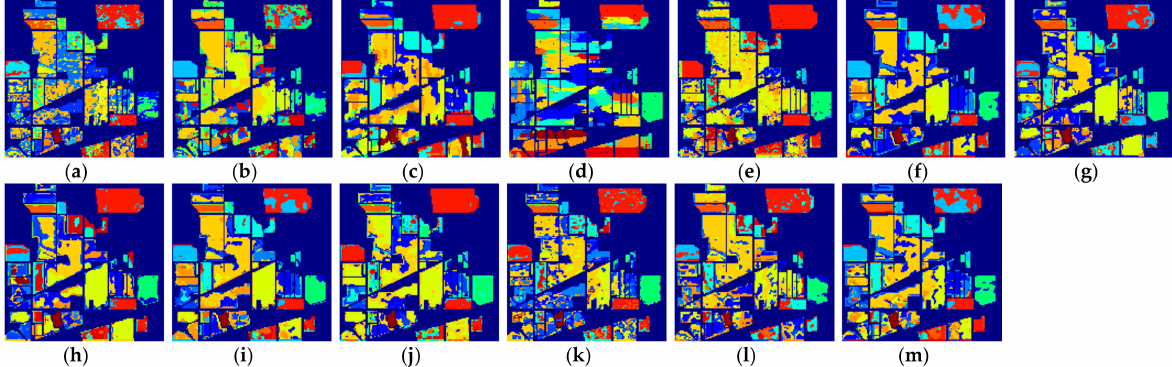
Figure 11. The classification maps of all methods with three samples on Indian Pines dataset. ( a ) SVM; ( b ) SS-LapSVM; ( c ) 3D-DENSEnet; ( d ) 3D-Gan; ( e ) SS-CNN; ( f ) 3D-CNN; ( g ) 3D-CNN k - means ( h ) 3D-CNN ours ; ( i ) 3D-CNN hardlabel ; ( j ) SSRN; ( k ) SSRN k - means ; ( l ) SSRN ours ; ( m ) SSRN hardlabel .